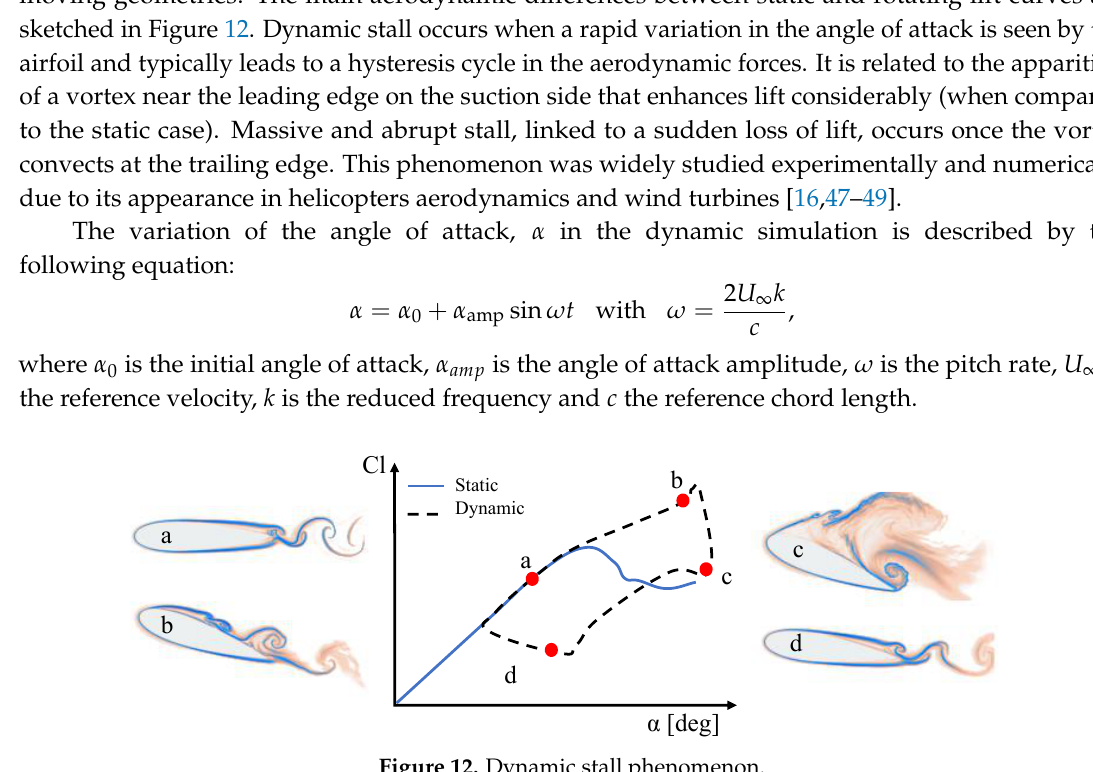
Figure 12. Dynamic stall